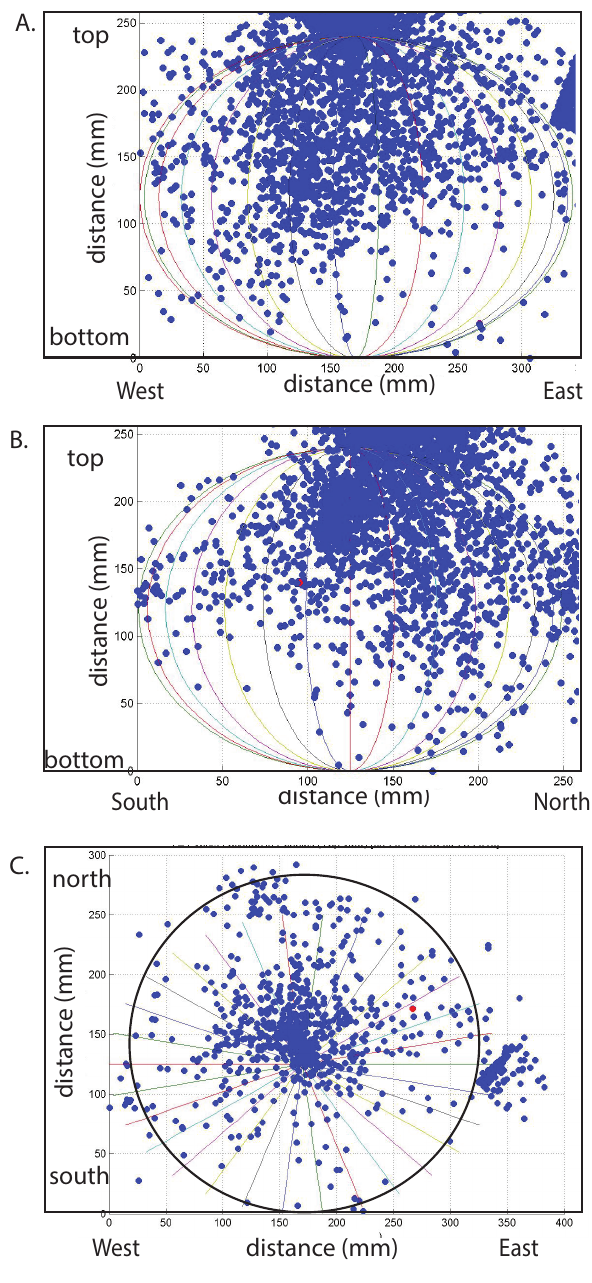
Fig. 6. Graphical representation of the location of events as calcu- lated by AEwin software for (A) a west to east side view of the test specimen, (B) a south to north side view of the test specimen and (C) a top-down view of the test specimen. In all figures, the ellipsoid shape is an approximate location of the surface of the rock based on its maximum dimensions. The events that are plotted are those that fall within 5cm of the ellipsoid shape (5051